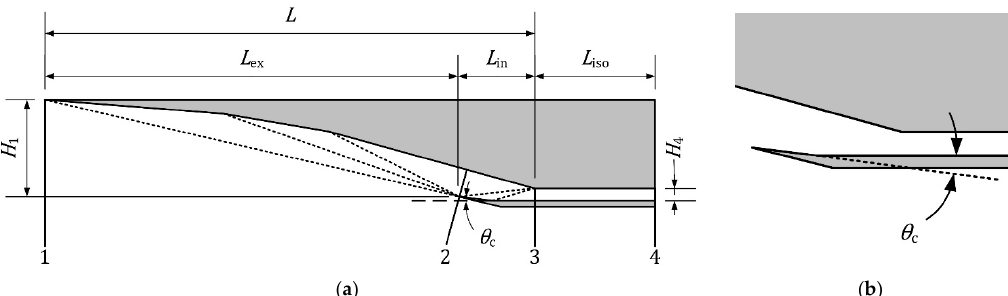
Figure 1. Schematic of a two-dimensional scramjet inlet. ( a ) schematic of geometric parameters; ( b ) close-up of the cowl.